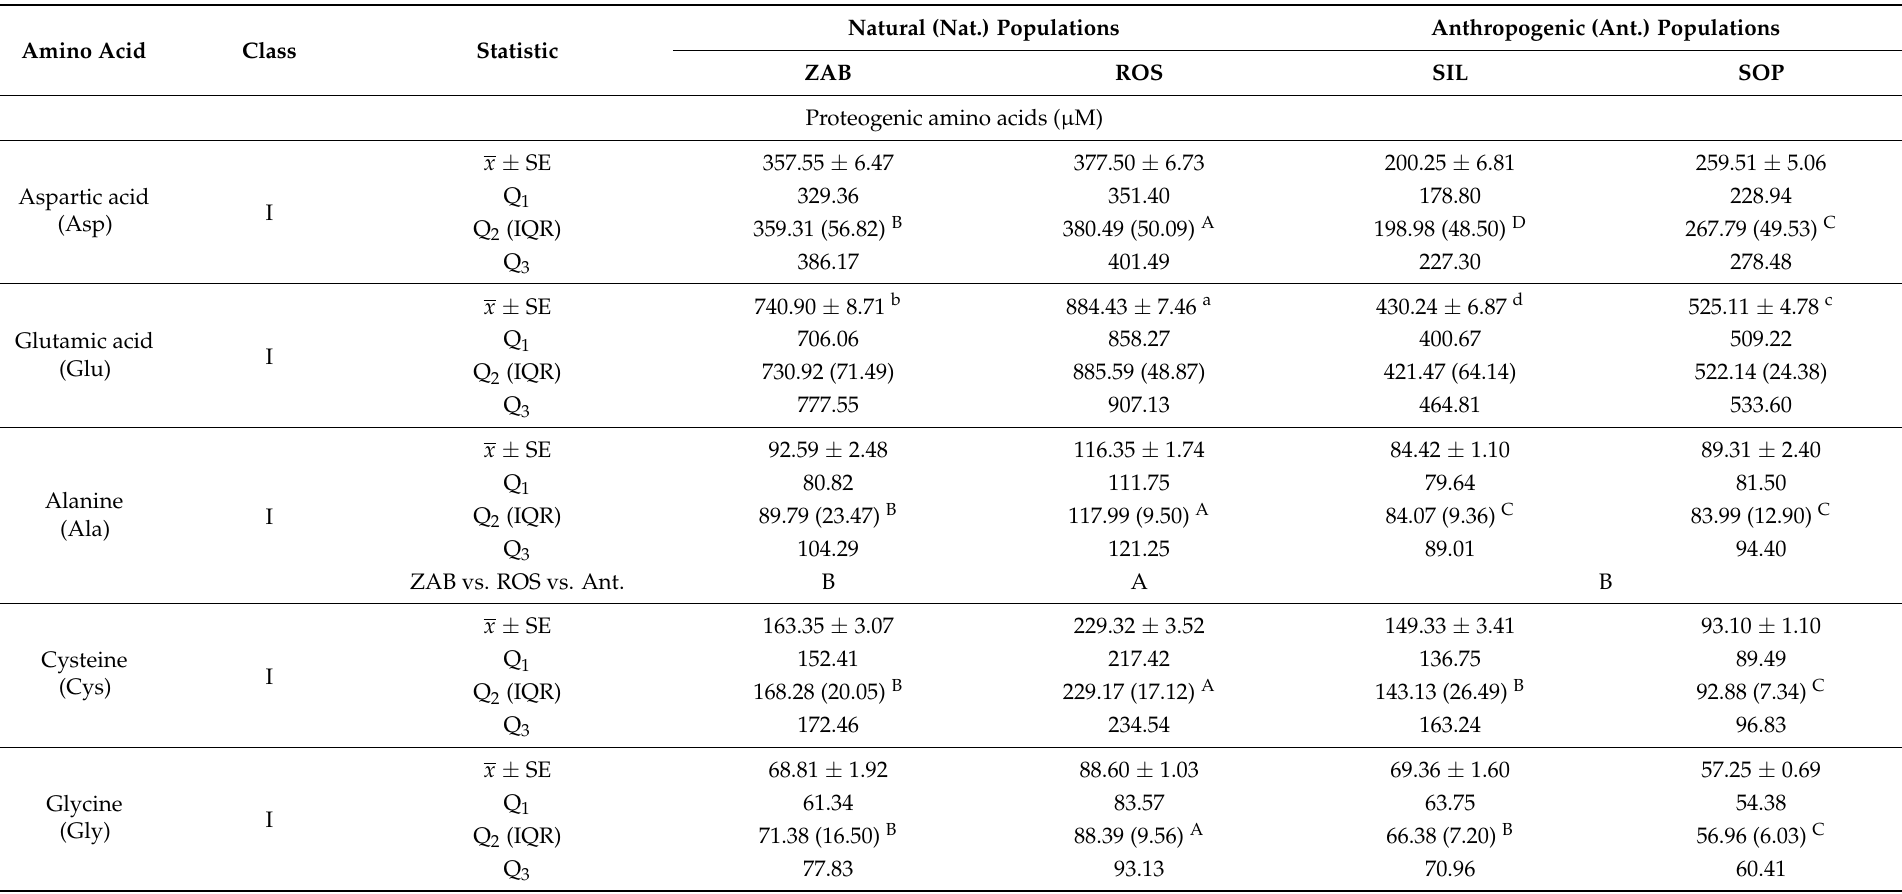
Table 2. The concentration of amino acids ( µ M) and total amount of amino acids (mg/mL) in Epipactis palustris nectar. The number of classes represents the effect of amino acids on insect chemoreceptors: I—no effect; II—inhibition of chemoreceptors; III—stimulate the salt cell; IV—the ability to stimulate the sugar cell. Data ( n = 30) represent the mean ( x ) ± standard error